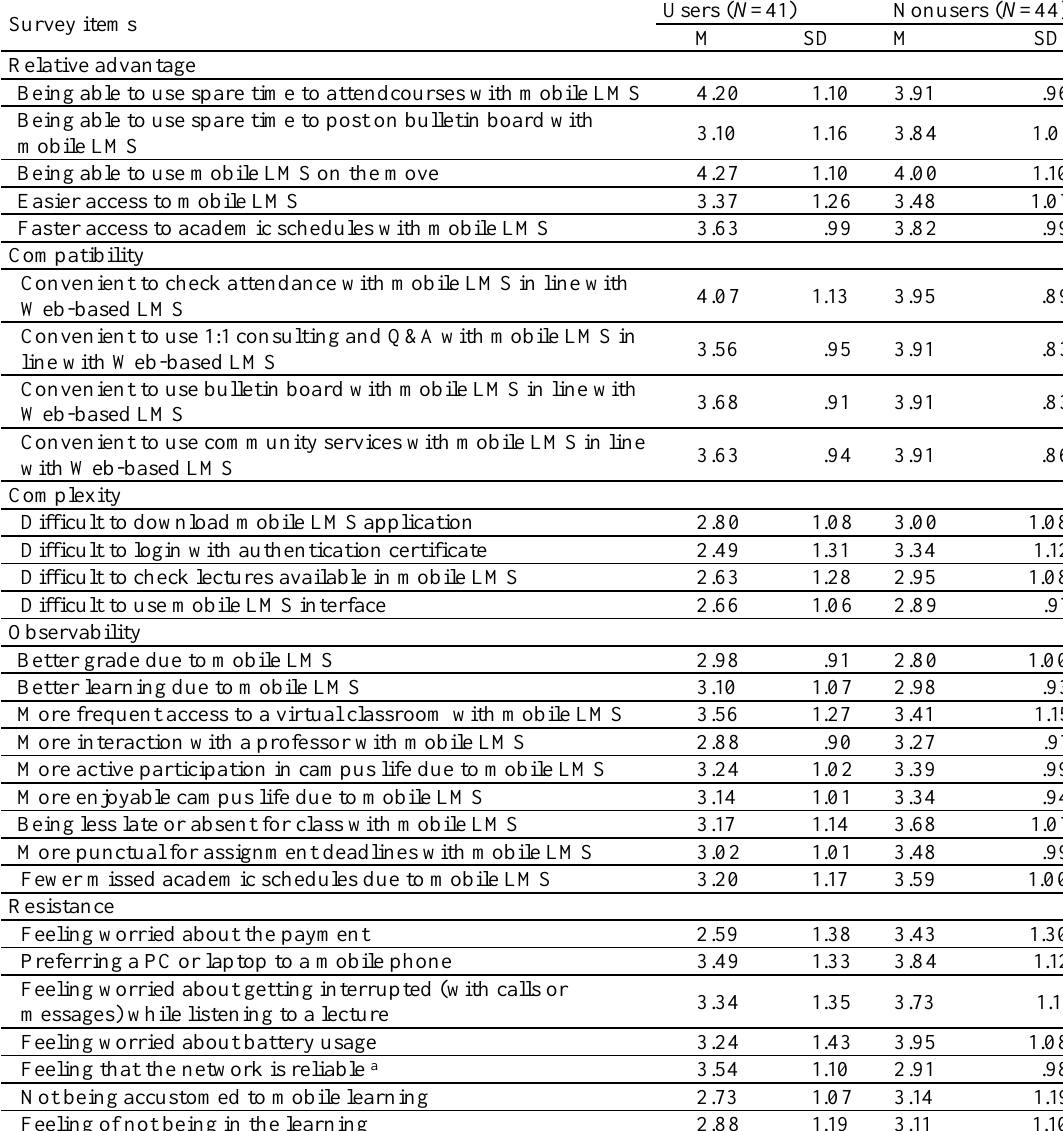
Means and Standard Deviations of the Participants’ Answers to the